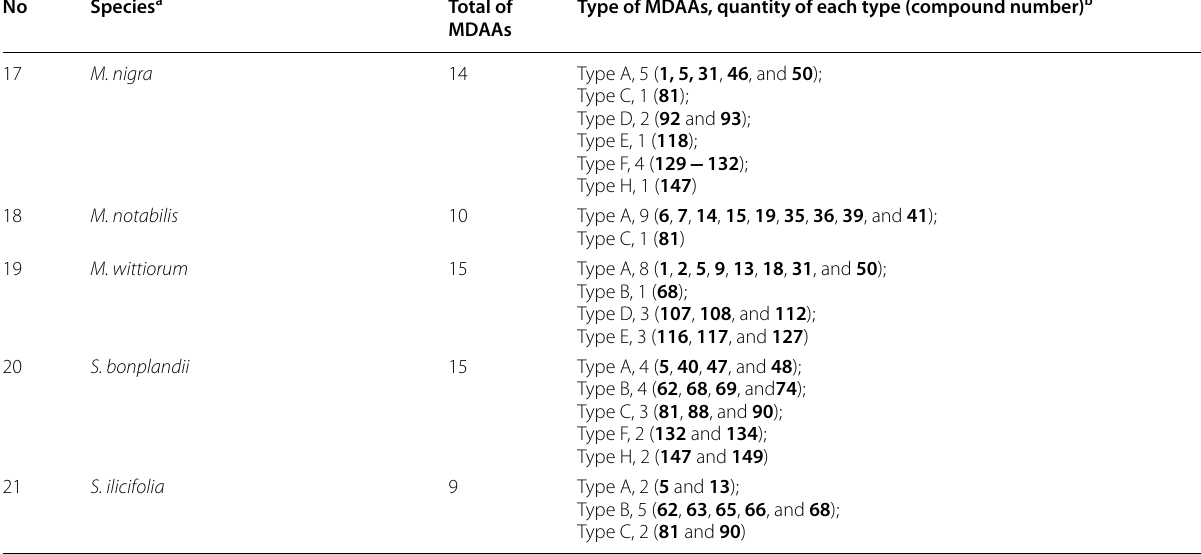
2.5 Dehydroprenyldihydroflavone type MDAAs (Type E) Fourteen type E MDAAs have been reported to date, as exemplified by 114 (Fig. 8), all sharing the dehy- − 127 droprenyldihydroflavone diene. The location of the dehy- droprenyl at dihydroflavone result in two subgroups: type E-I (the diene moiety on ring B) and type E-II (the diene moiety on ring A). 2.5.1 Type E with the diene moiety on ring B (Type E‑I) Among the reported type E-I MDAAs, all compounds having the diene moiety on ring B (all at C-3 ′ ) are trans– trans configuration. Guangsangons M and N ( 114 and 115 ) are a pair of the 2-epimers, which were iso- lated from the stem barks of M. macroura by Dai et al . in 2004 [74]. Wittiorumin D ( 116 ) and its prenylated derivative wittiorumin E ( 117 ) with the same 2 S con- figuration were obtained from M. wittiorum by Tan et al. in 2009 [22]. Kuwanon L ( 118 ) [118] and its pre- nylated derivative kuwanon O ( 119 ) [110] wereisolated from M. alba in 1983 and M. lhou in 1984, respectively, in which the configurations of C-2 were not yet deter- mined. Guangsangon D ( 120 ) [85], guangsangon H ( 121 ) [17], guangsangon K ( 122 ) [74], and guangsangon F ( 123 ) [74] all having a hydroyl group at C-2 are 2 R ,3 R configurations. Their dienes also could be regarded as